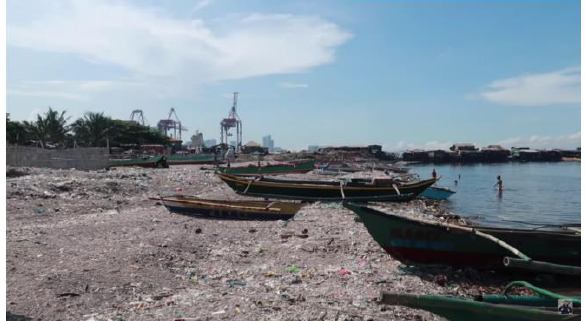
Figure 10 . Trash mixed with the sand in BASECO beach area.